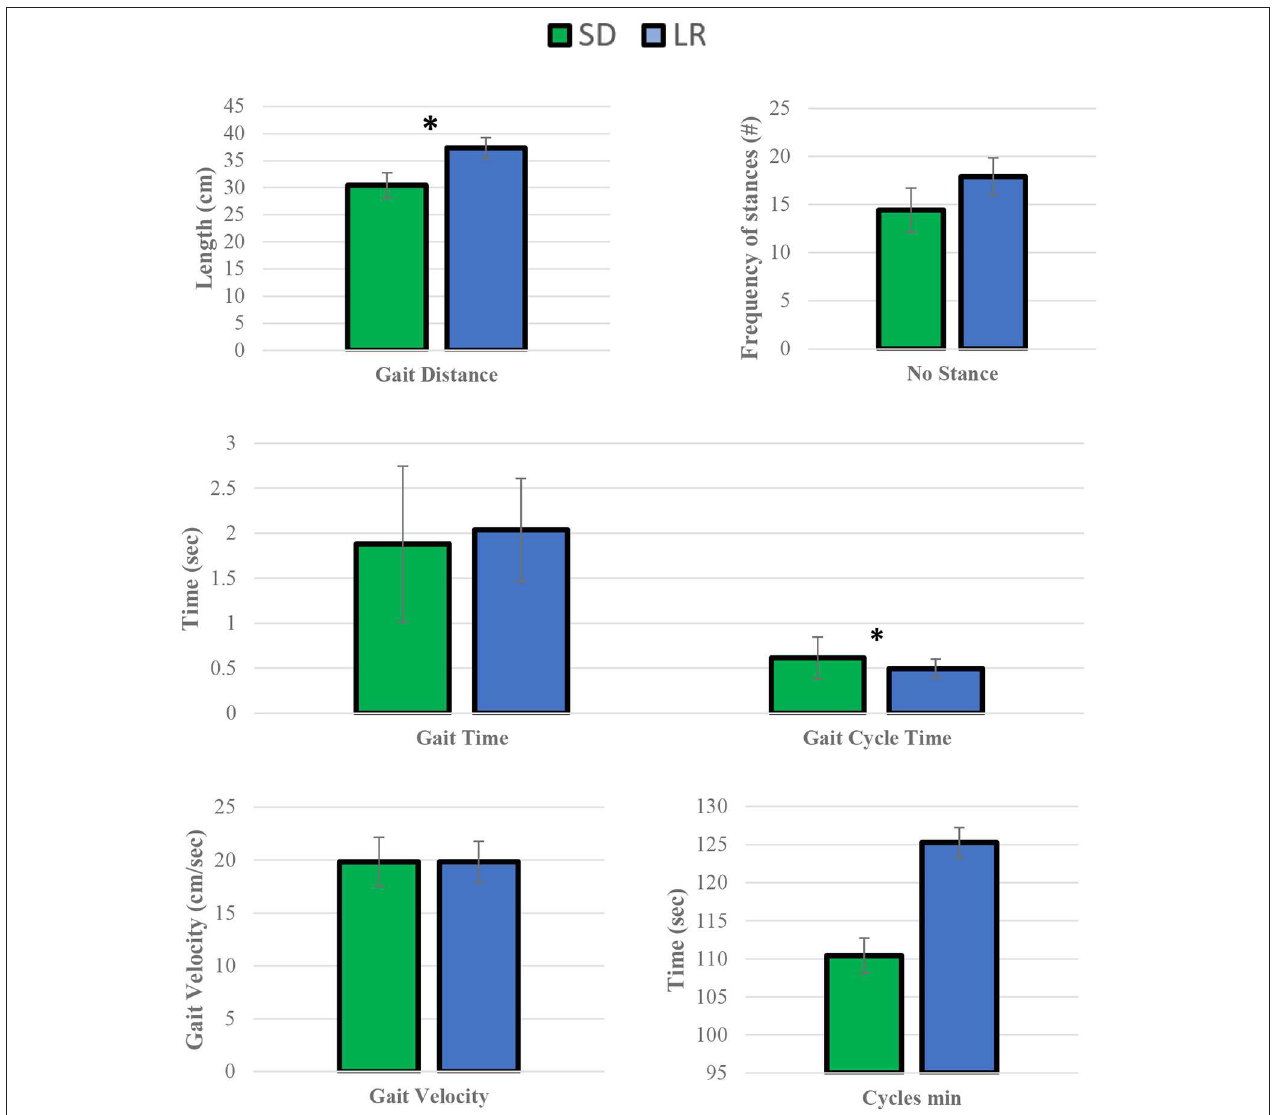
FIGURE 6 | Mean temporal parameter values. Sprague Dawley (SD) and Lewis (LR) rats paired t -test. * P ≤